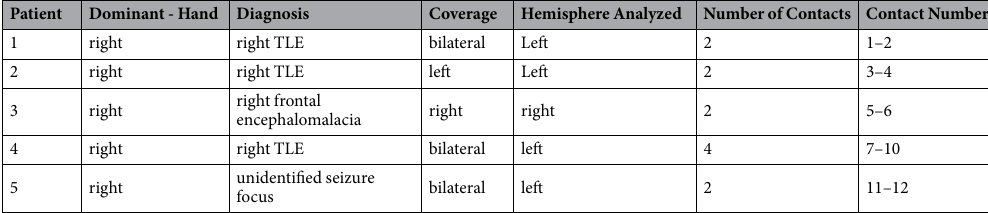
Table 1. Patients’ information, hemisphere included in the analyses, number of contacts in the hippocampus, and their number and locations. Note: TLE = temporal lobe epilepsy.